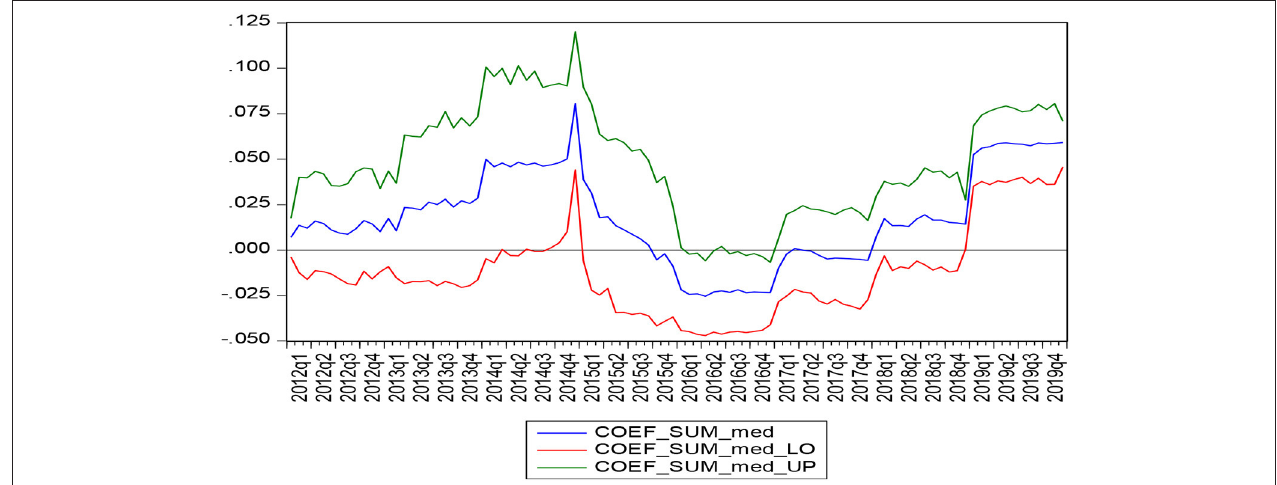
FIGURE 3 | Estimated results of boot rolling (medical expenditure - consumer